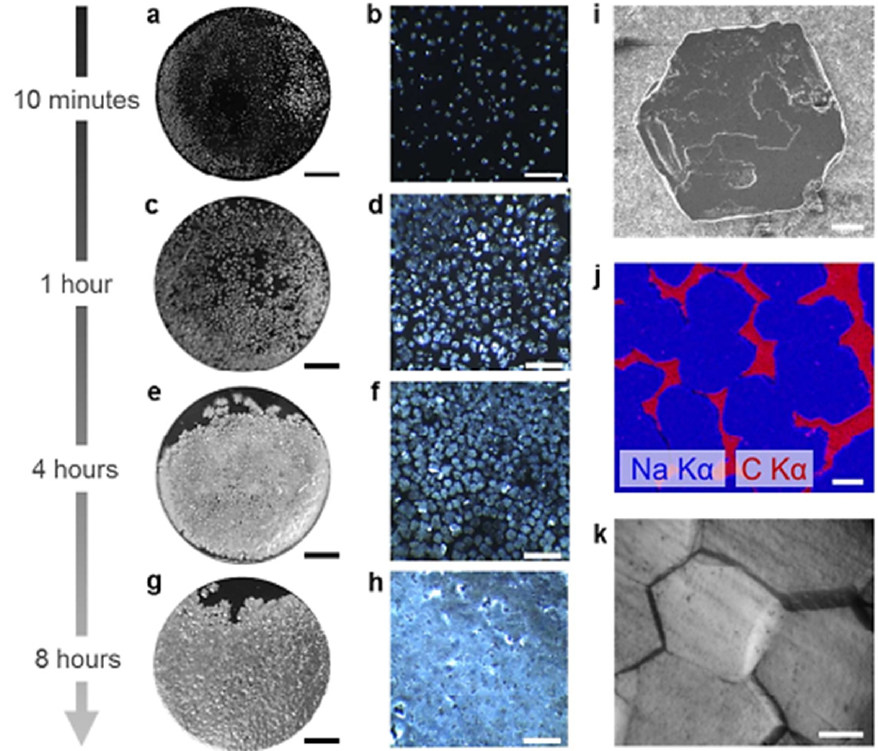
Figure 6. SEM images of sodium metal on carbon/Al electrodes following plating at 0.5 mA · cm 2 after ( a , b ) 10 min, ( c , d ) 1 h, ( e , f ) 4 h, and ( g , h ) 8 h. ( i ) SEM image of hexagon-shaped sodium metal island (SB = 20 µ m). ( j ) EDS map showing coalescing sodium metal islands (CB = 50 µ m). ( k ) Micrograph of plated sodium metal film with 4 mAh/cm 2 loading (SB = 20 µ m) (adopted with [49]; copyright (2006) American Chemical Society).